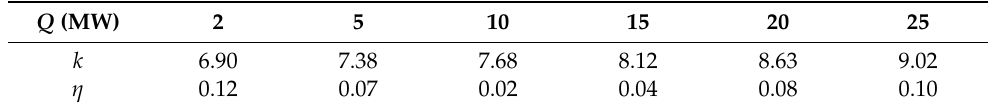
Table 4. The values of coefficient k and η .